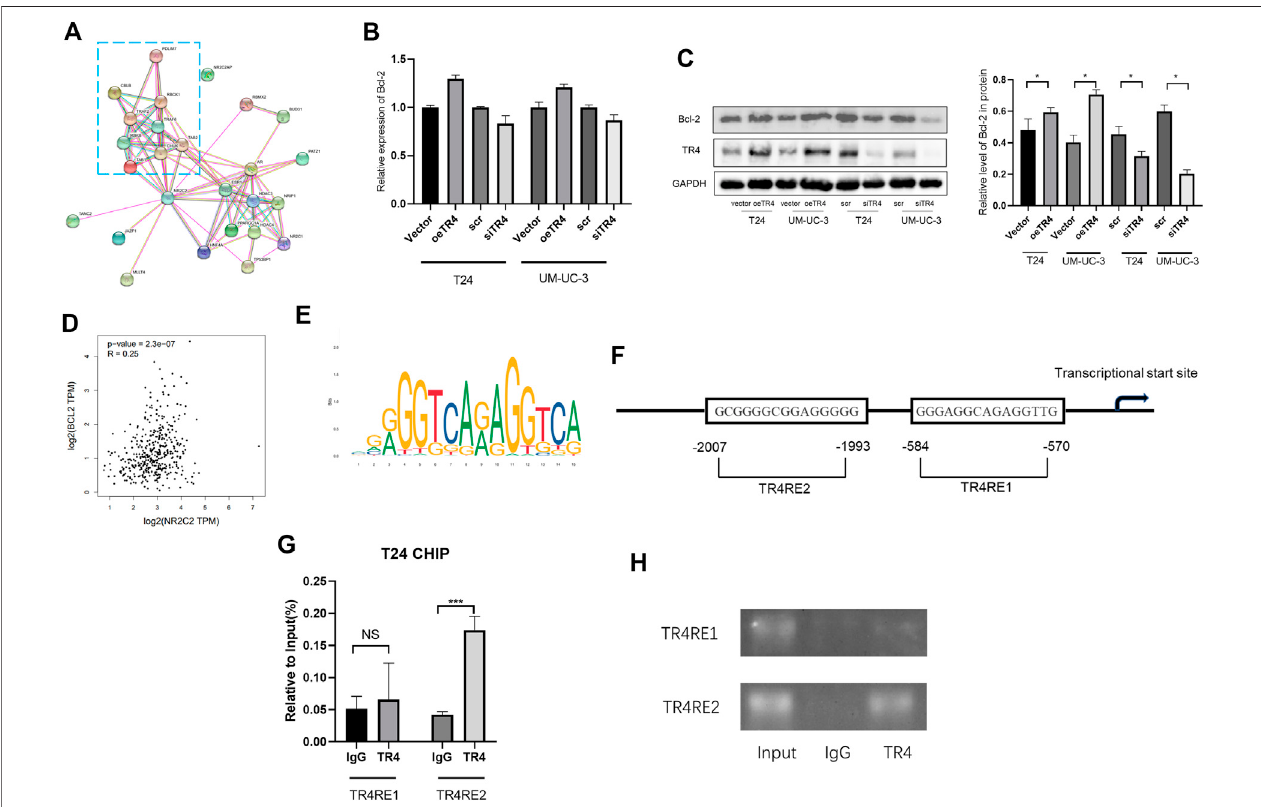
FIGURE 4 | TR4 altered cell apoptosis of bladder cancer via Bcl-2: (A) The interaction network of TR4 was constructed, and the most relevant proteins involved in thecellapoptosispathwaywereenclosedinabluerectangle. (B) Bcl-2mRNAexpressionwasveri fi edbyqPCRaftertransfectingVector,oeTR4,scr,andsiTR4. (C) Bcl- 2 protein expression wasveri fi ed byWesternblot after transfecting the Vector, oeTR4, scr, and siTR4.GAPDHwasused asthe internal reference. Semiquanti fi cation of Bcl-2basedonthebanddensityfromthreeindependentexperimentswasshownintherightpanel,* p < 0.05. (D) GEPIAwasusedtoanalyzetheco-expressionof TR4andBcl-2inbladdercancer.Spearman (cid:2) 0.25, p < 0.01. (E) TR4motifsequencewaspredictedbyJaspar. (F) Bcl-2promoterregionscontainpotentialTR4binding sites (TR4RE1 and TR4RE2). (G) and (H) ChIP assay results showed that TR4 binds to TR4RE2, NS: no signi fi cant, *** p <